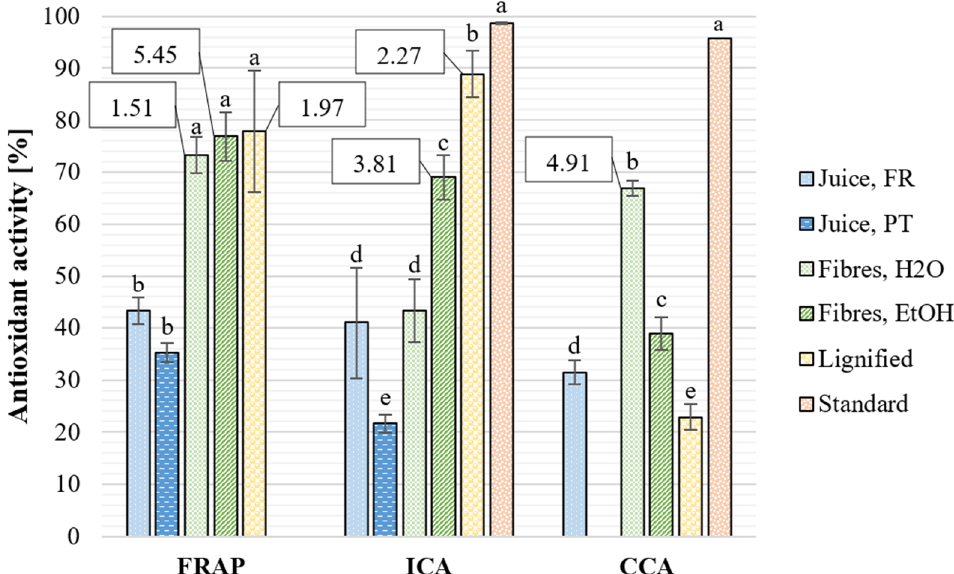
Figure 3. Antioxidant activity [%] of extracts from S. ramosissima at the concentration of 10 mg/mL in relation to blank samples with extraction solvent determined by assays with metal-based antioxidant mechanisms. FRAP: ferric reducing antioxidant power, ICA: iron chelating activity, CCA: copper chelating activity. EC50 values [mg/mL] are presented in callout boxes for Salicornia samples with activity more than 50%. The standard compound is ethylenediaminetetraacetic acid (1 mg/mL). Different letters denote significantly different results, calculated individually for the results from each assay and for all assays ( p < 0.001).